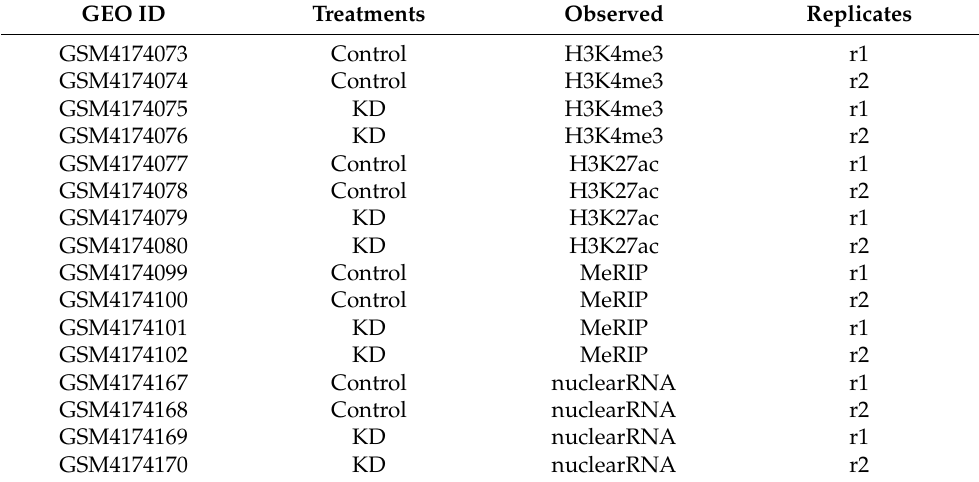
Table 1. Sample tables for HEC-1-A human cancer cell lines.